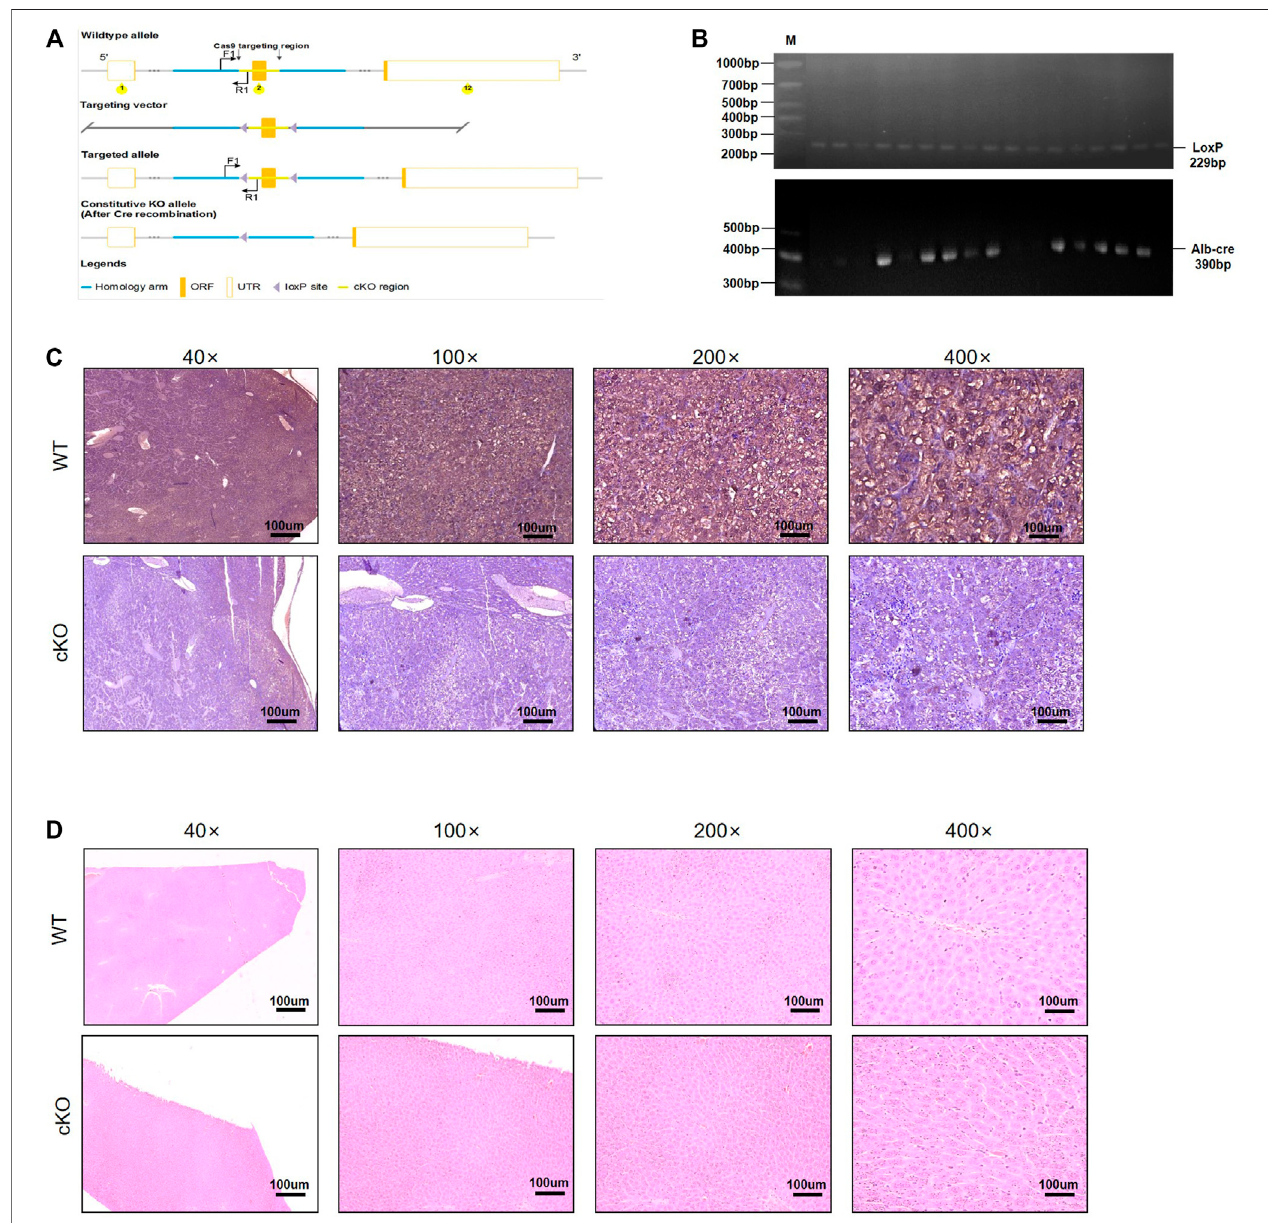
FIGURE 1 | Generation of hepatocyte-speci fi c NFIB-knockout mice (N fi b f/f Alb-Cre). (A) NFIB gene knockout targeting vector strategy design diagram. (B) Genotyping of N fi b loxp/loxp Alb-cre (N fi b f/f Alb-Cre) mice using the tail DNA. The above panel shows the homozygous loxp mice. The wild-type (WT) allele yields an ampliconof162bp,whilethe fl oxedalleleyieldsanampliconof229bp.ThepanelbelowshowstheAlb-Crepositivemice,withanampliconof390bp. (C) IHCanalysisof NFIBproteinintheliversofWTandN fi b f/f Alb-Cremice. (D) H&EstainingshowingthehistologyoftheliversofWTandN fi b f/f Alb-Cremice.Allscalebars =100 μ m. Original magni fi cation×20. IHC,